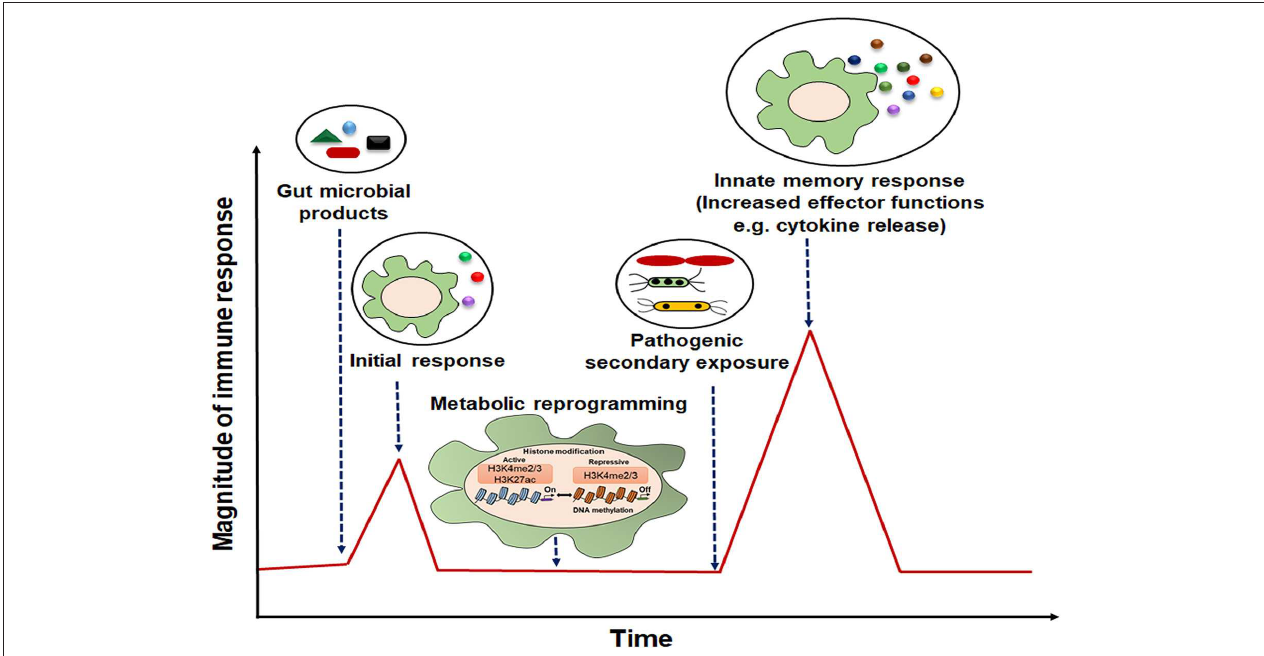
FIGURE 2 | Representative model of innate immune memory response. After initial exposure to gut microbial components, innate cells with “memory” traits respond rapidly with high magnitude of immune response to the secondary